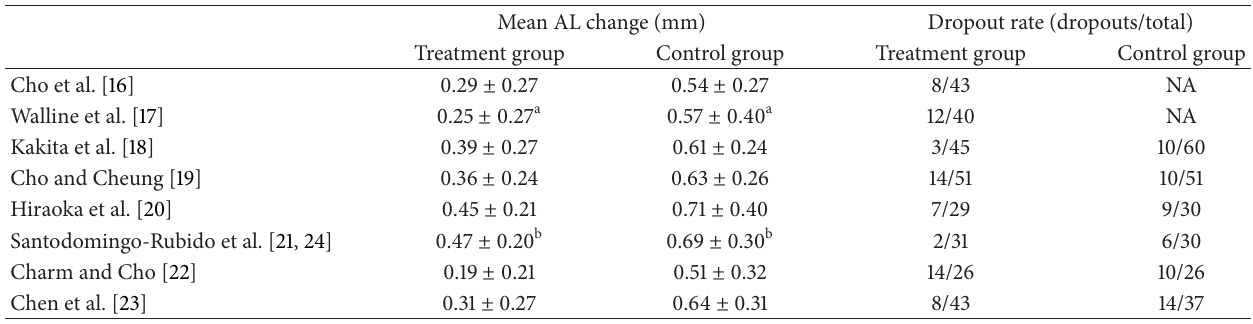
Table 2: Efficacy (mean AL change) and acceptability (dropout rate) in each study at 2-year follow-up.